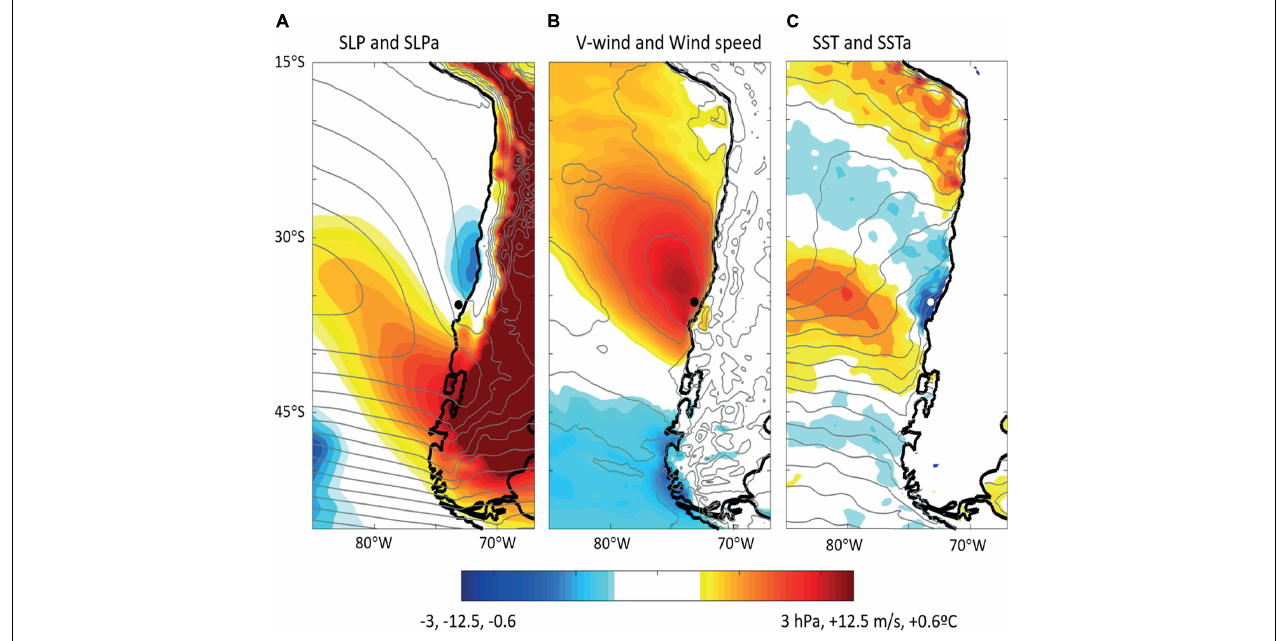
FIGURE 11 | Composite maps 24 h before the upwelling events demise constructed using ERA5 reanalysis data. (A) Sea level pressure (contours) and sea level pressure anomalies (colors), (B) Meridional wind (contours) and wind speed (colors), (C) Sea surface temperature (contours) and sea surface temperature